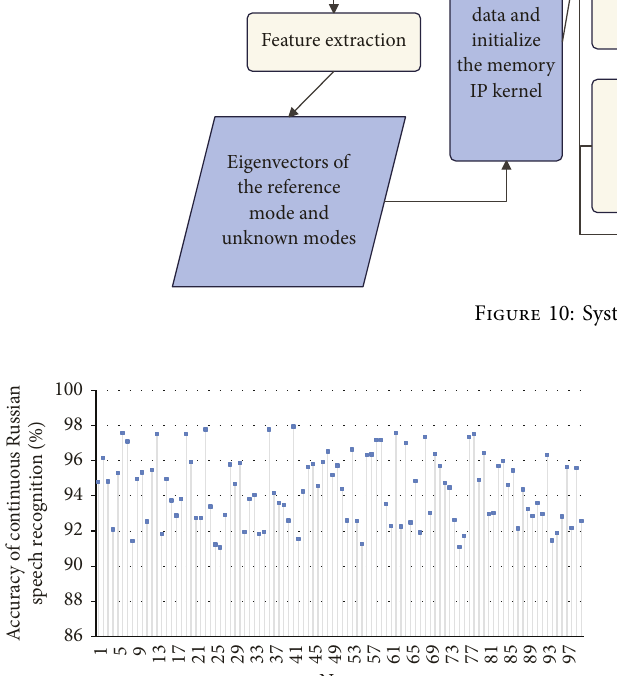
Figure 11: The accuracy of Russian recognition of the DTW-based Russian continuous speech recognition